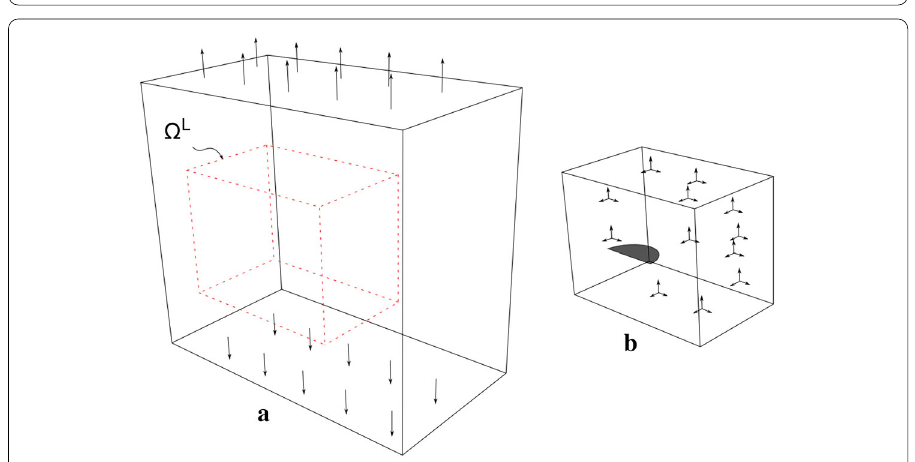
Fig. 14 Initial global and local problem used in the GFEM gl analysis of a surface crack— a initial global problem with subdomain (cid:2) L shown— b local problem with boundary conditions on ∂(cid:2) L \ ( ∂(cid:2) L ∩ ∂(cid:2) ). a shows that the initial global step does not model the surface crack. b Shows that the crack is introduced in the local step